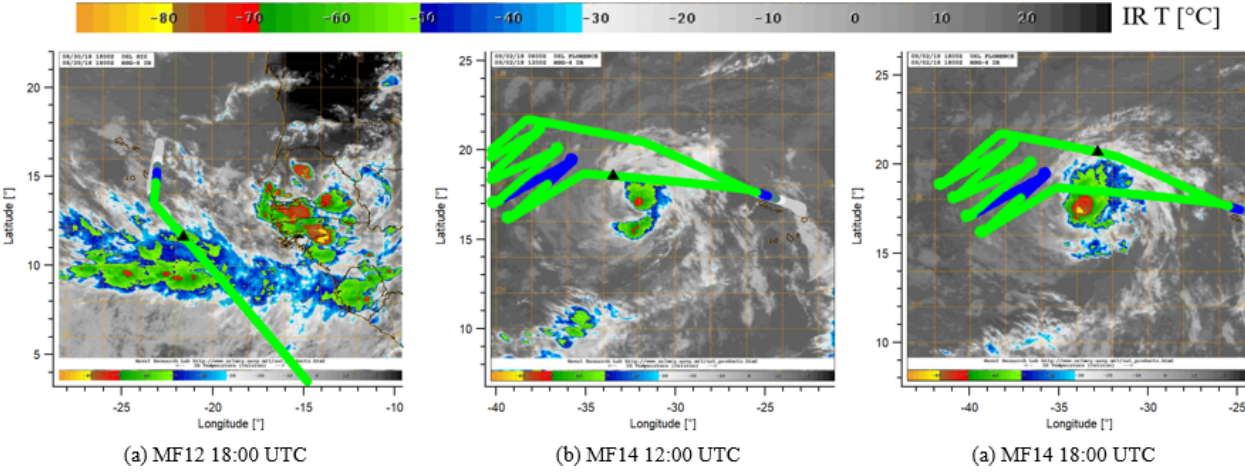
Figure 2. Flight tracks with color-enhanced infrared imagery obtained from the Naval Research Laboratory Tropical Cyclone page (Naval Research Laboratory, 2020) for MF12 and MF14 (no image availability before MF12 18:00UTC). The altitude of the flight tracks is colored according to the IR temperature legend. The temperature during most parts of the flight was between − 50 and − 60 ◦ C. Black triangles show the according position of the research aircraft for the time of the background IR